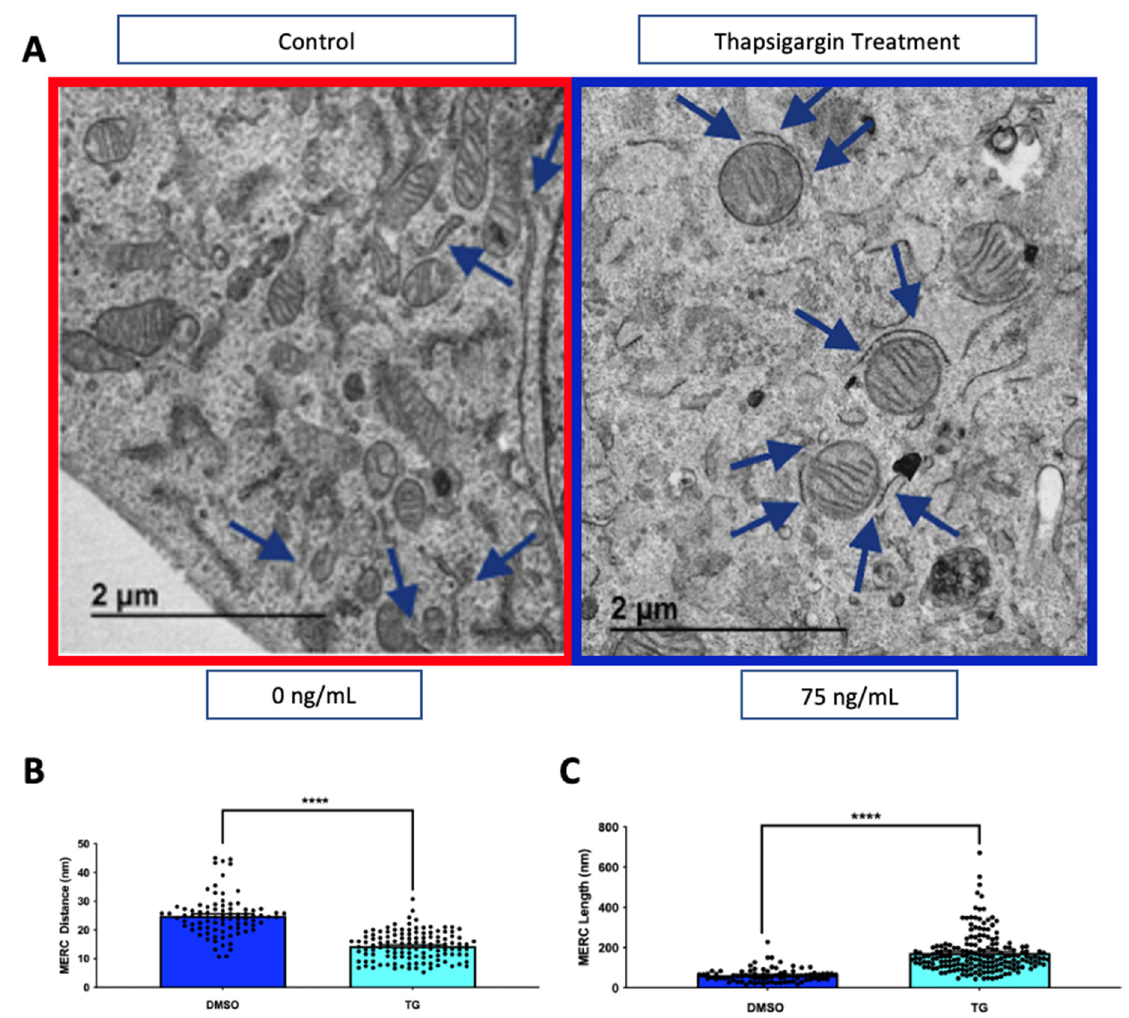
Figure 5. Thapsigargin treatment increases mitochondria-endoplasmic reticulum contacts (MERCs). ( A ) Representative TEM images of mouse skeletal myotubes from untreated (DMSO, red outline) and thapsigargin-treated (blue outline) myotubes. MERCs are identified with blue arrows. ( B ) Quantification of MERC distance and ( C ) MERC length. Statistical significance is indicated by asterisks, **** indicate p ≤ 0.0001.